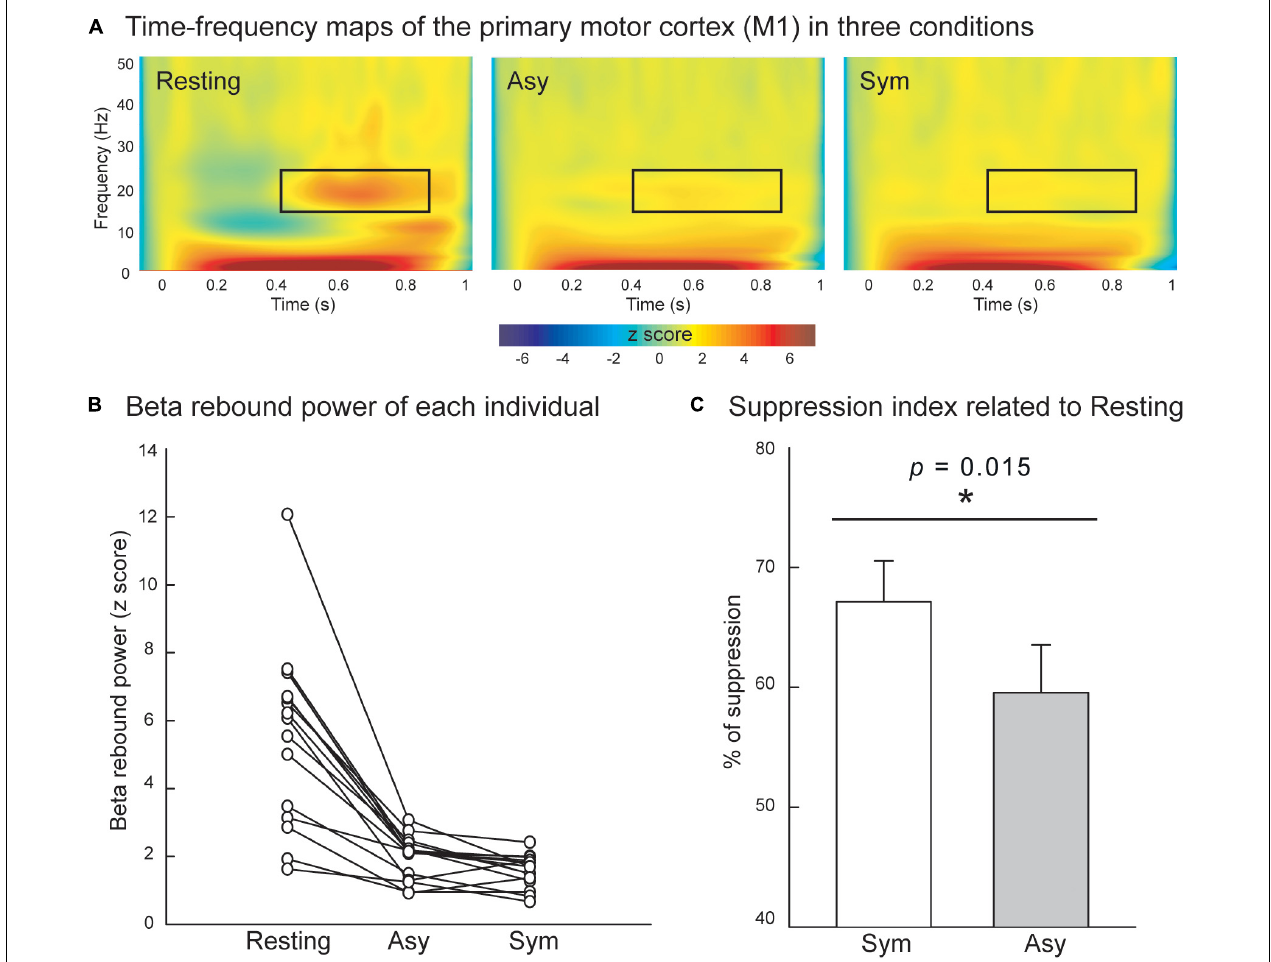
FIGURE 3 | (A) Grand-averaged time–frequency maps of electricity-induced beta rebound oscillations (black rectangles) of the right primary motor cortex (M1) in the resting, Asy, and Sym conditions. (B) The M1 beta rebound strength from each individual in the resting, Asy, and Sym conditions. (C) The suppression index refers to the extent of beta power suppression in Sym and Asy with respect to the resting condition. The beta rebound oscillations were suppressed more in the Sym than in the Asy condition. ∗ Represents significant effect ( p <